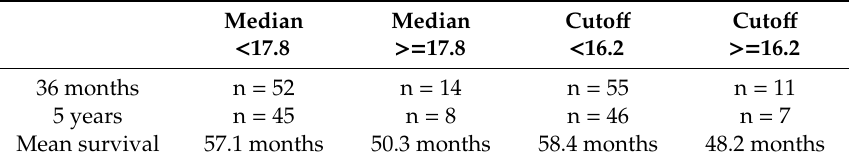
Table 3. Survival time for patients depending on the median and cuto ff level of galectin 3.